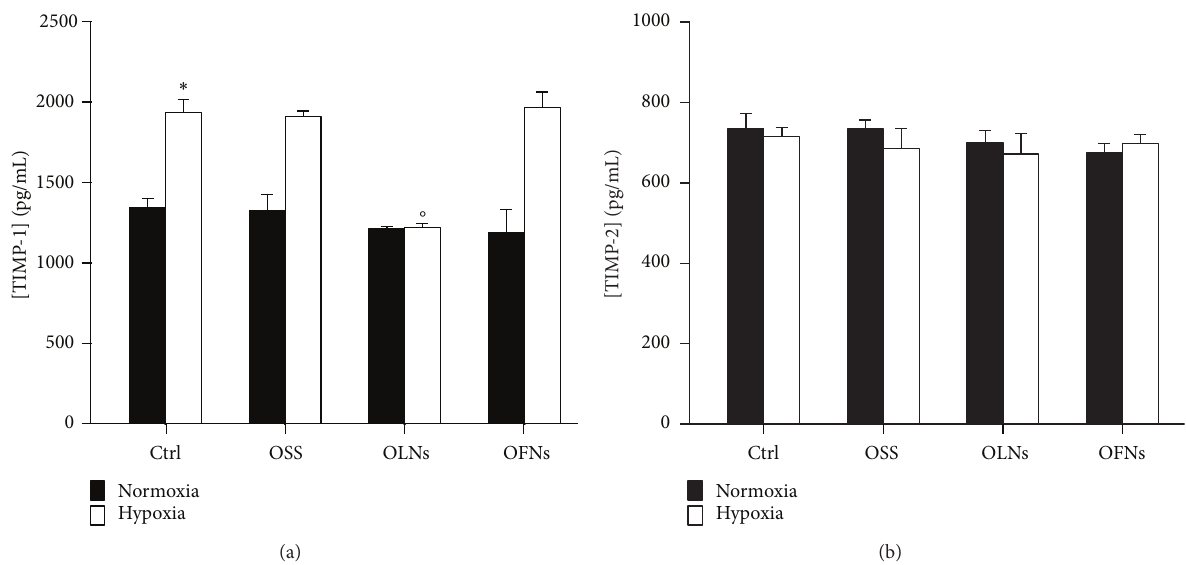
Figure 4: Hypoxia and OLN effects on protein levels of gelatinase inhibitors (TIMP-1 and TIMP-2) secreted by human monocytes. Human adherent monocytes (10 6 cells/2 mL Panserin 601 medium) were left untreated or treated with 200 𝜇 L OLNs, OFNs, or OSS for 24 h in normoxia (20% O 2 ; black columns, both panels) or hypoxia (1% O 2 ; white columns, both panels). After collection of cell supernatants, TIMP- 1 (panel (a)) and TIMP-2 (panel (b)), protein levels were quantified by ELISA. Results are shown as means + SEM from three independent experiments. Data were also evaluated for significance by ANOVA: ∗ versus normoxic control cells: 𝑃 < 0.02 (panel (a)) and 𝑃 not significant (panel (b)); ∘ versus hypoxic control cells: 𝑃 < 0.02 (panel (a)) and 𝑃 not significant (panel (b)).